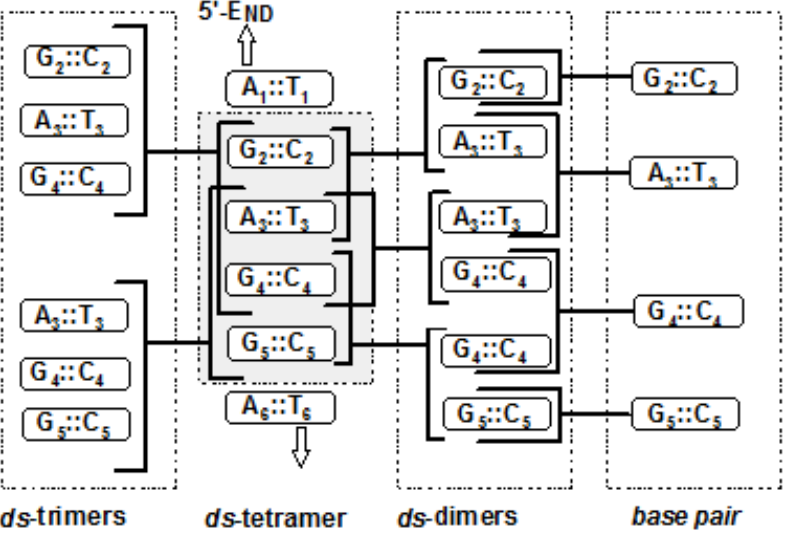
Figure 2. Graphical representation of ds -oligonucleotides divided into two ds -trimers, three ds -dimers, and four base pairs (indicated by dashed squares).